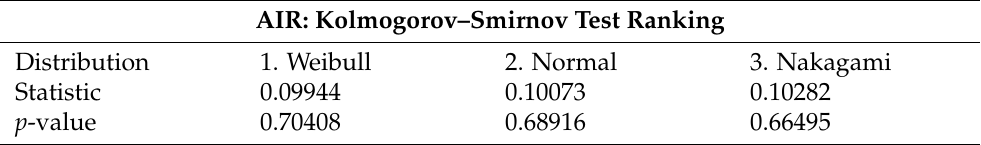
Table 8. Kolmogorov–Smirnov test values for the three best fitted two-parameter distributions for the air influence.